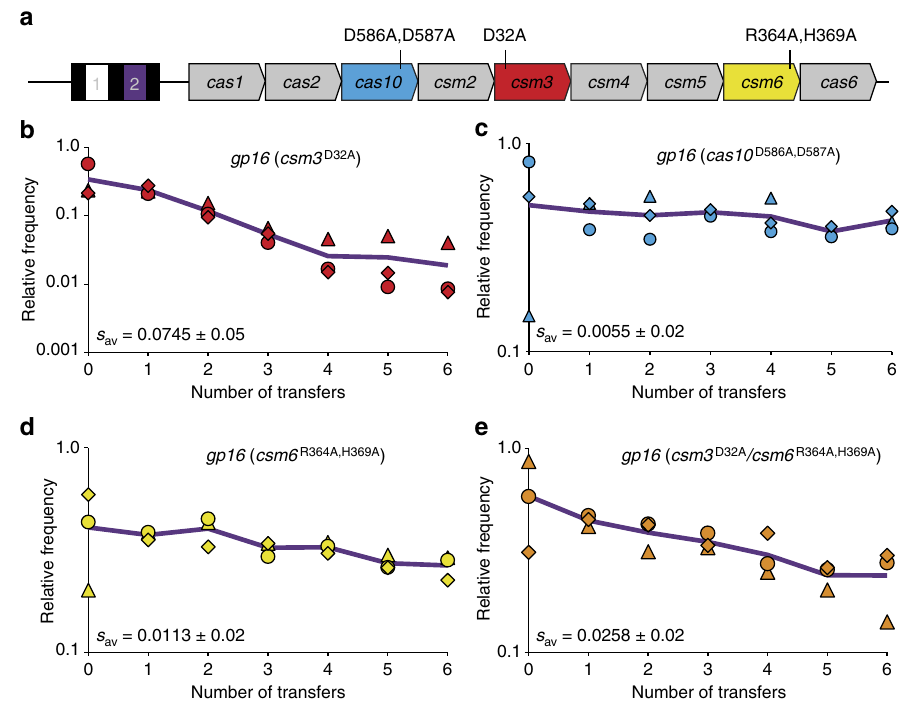
Fig. 2 Effect of targeting nuclease active site mutations on fi tness costs associated with type III-A systems. a Schematic diagram summarizing the arrangement of CRISPR – Cas loci used throughout the work, with position 2 of the CRISPR array occupied by the gp16 spacer (purple rectangle) in this example. The naturally occurring nes spacer (white rectangle) from S. epidermidis RP62a is maintained at position 1 in all cases. Open reading frames (ORFs) encoding Cas nucleases implicated in targeting are highlighted in blue ( cas10 ), red ( csm3 ), or yellow ( csm6 ), and the positions of their active site mutations are labeled to scale within each ORF. Other features of the diagram are not drawn to scale. b – e Pairwise competition experiments for mutant CRISPR – Cas plasmids harboring the gp16 spacer with perfect matches to Φ NM1. In each case, an Erm R -marked control lysogen harboring the wild-type parent vector with non-targeting spacers was competed against a Tet R -marked lysogen harboring a mutant CRISPR – Cas plasmid with the gp16 spacer. Relative frequencies ( y -axis) are plotted against the number of transfers ( x -axis), with one transfer per day. Individual values from each biological replicate ( n = 3) are depicted as a triangle, circle, or rhombus, and are colored to match the ORFs highlighted in a for each mutant, or orange for the csm3 / csm6 double mutant. Solid lines represent the average change in relative frequency across the three replicates, and are colored purple to match the gp16 spacer ’ s target gene as outlined in Fig. 1. The s av values are derived from Supplementary Table 1 and provide mean ±